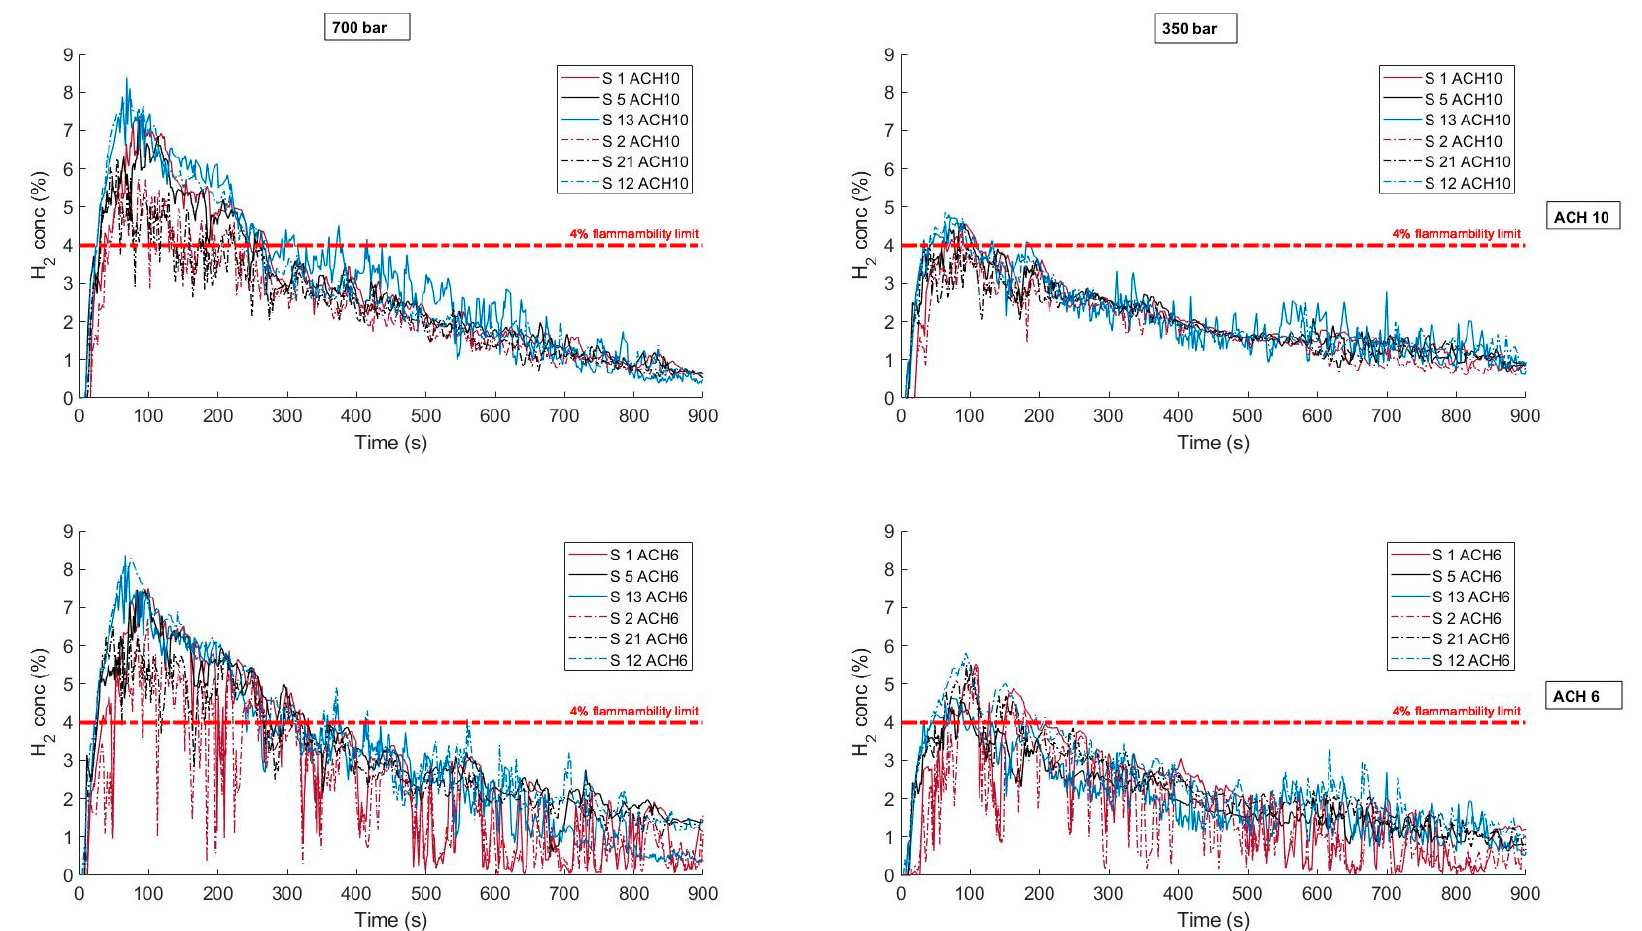
Figure 8. Concentration results from blowdown hydrogen releases with ventilation 10 ACH and 6 ACH. Solid lines-sensors mounted under the ceiling, dash lines-sensors mounted 50 cm under the ceiling.